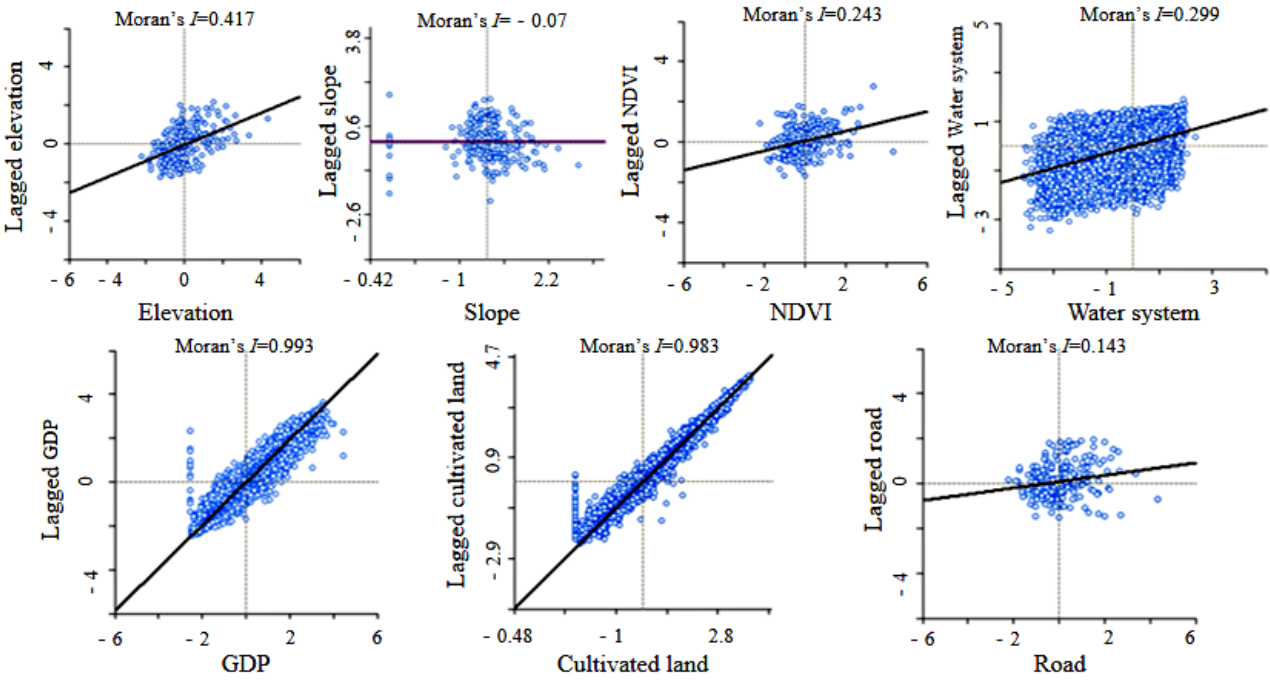
Figure 5. Scatter plot of the autocorrelation between the sustainable development index and various factors in the Miaoling Mountains.